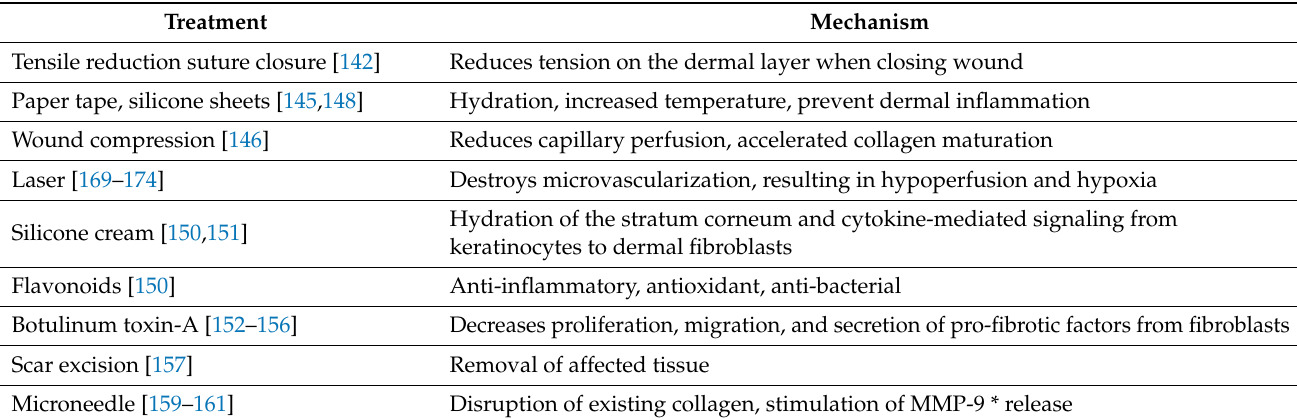
Table 2. Conventional treatments for hypertrophic